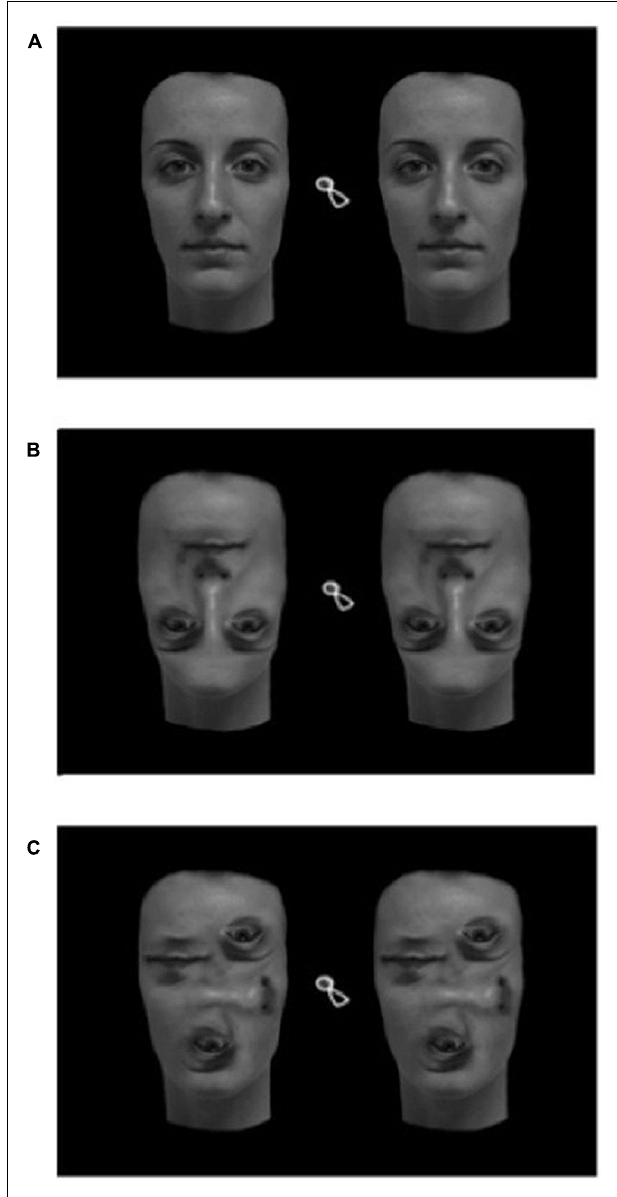
FIGURE 1 | Each stimulus was composed of two upright (A), inverted (B), or scrambled (C) faces. Original stimuli were colored.